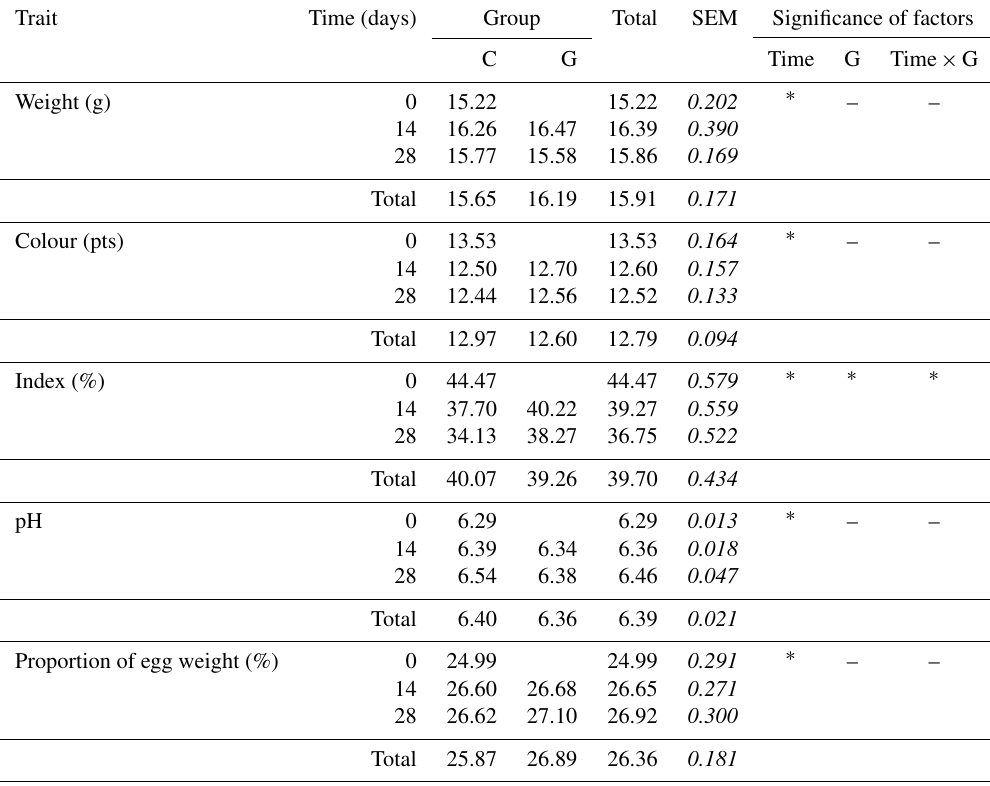
Table 3. Traits of egg yolk in the control and experimental groups.